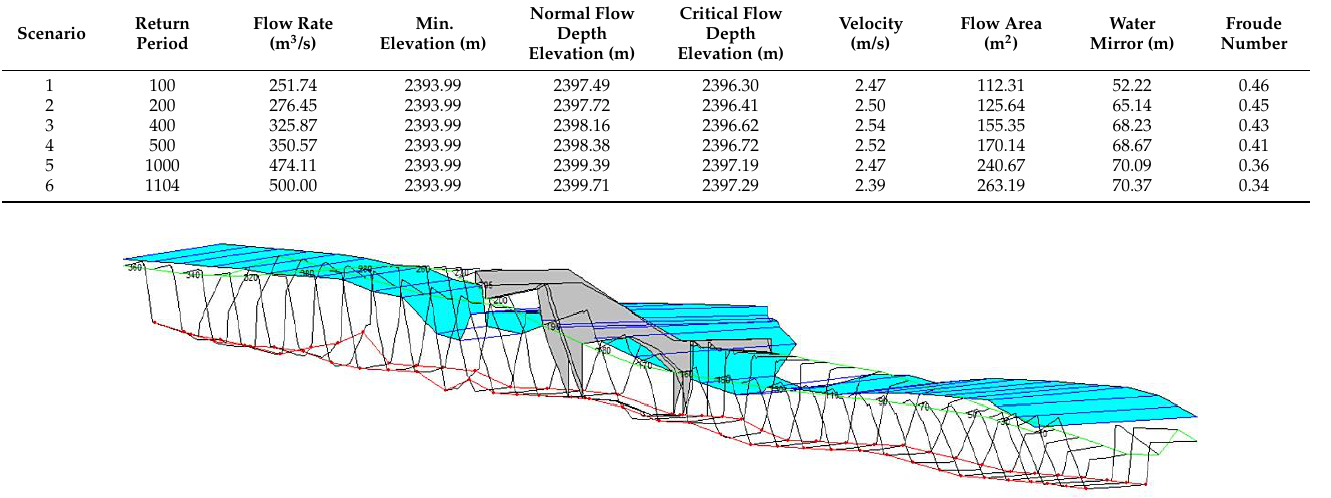
Figure 7. HEC-RAS hydraulic simulation for scenario 6, with a flow rate of Q=500 m3/s. Table 4. Results of the Extraordinary Maximum Water Level